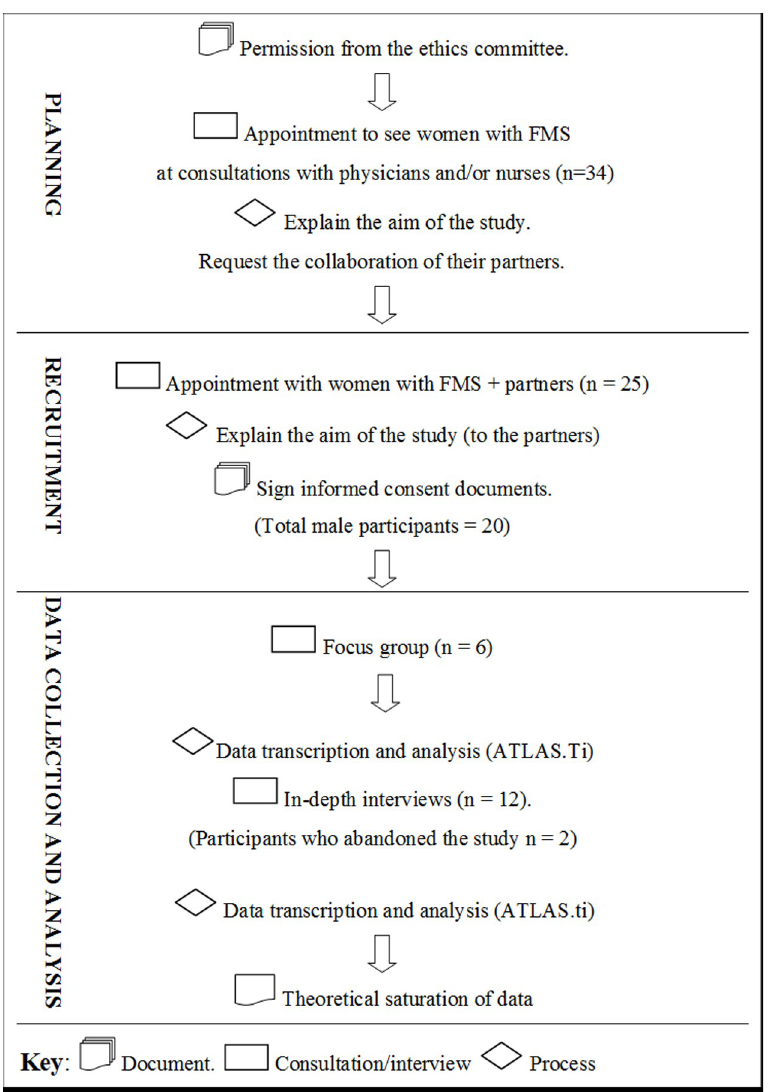
Fig 1. Recruitment of study participants. Eighteen participants comprised the final sample as two abandoned the data collection for professional and personal reasons (Table